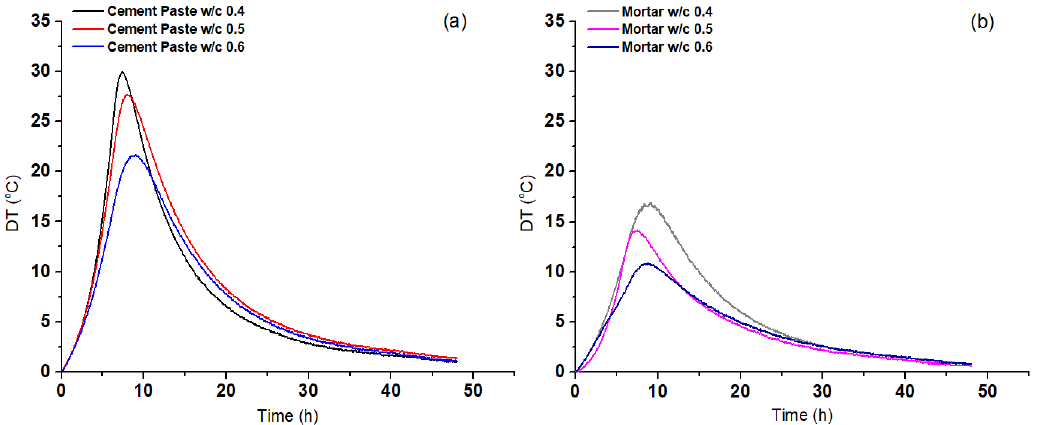
Figure 6. Temperature difference for various w/c ratios for ( a ) cement paste and ( b )